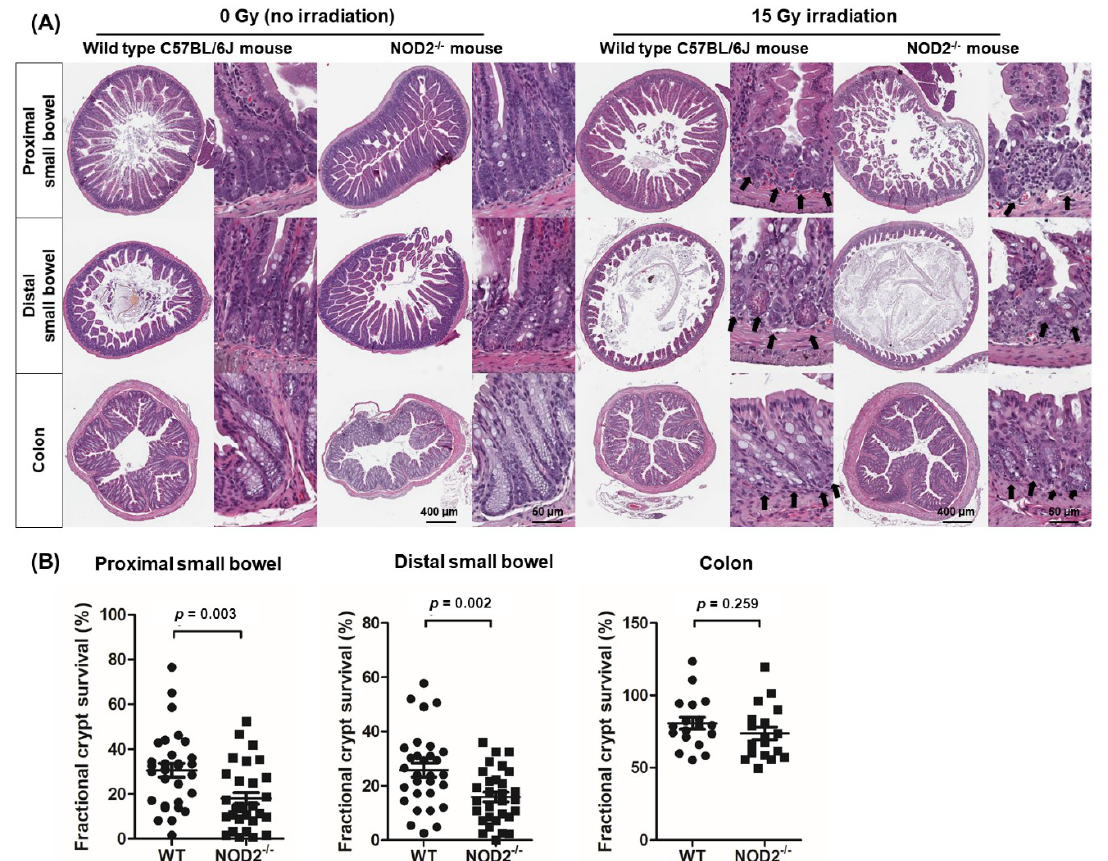
Figure 2. Location-dependent crypt survival after radiation injury in the WT and NOD2 − / − mice. ( A ) Crypt microcolony assay. Arrows indicated the regenerative crypts. ( B ) Fractional crypt survival rate according to different location of intestine. Differences were evaluated by two-way ANOVA followed by Bonferroni post-test.